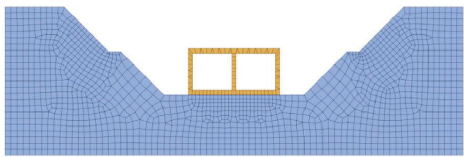
Figure 6: Two-dimensional model of the river-crossing